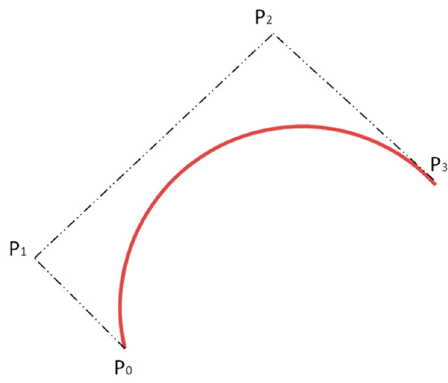
Figure 10. Third-order Bezier curve.